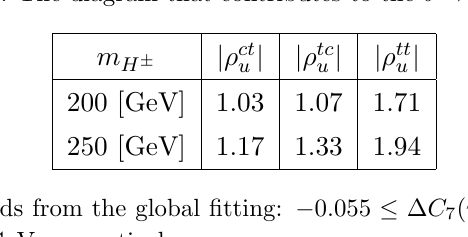
Figure 2 . The diagram that contributes to the b ! s(cid:13) process.